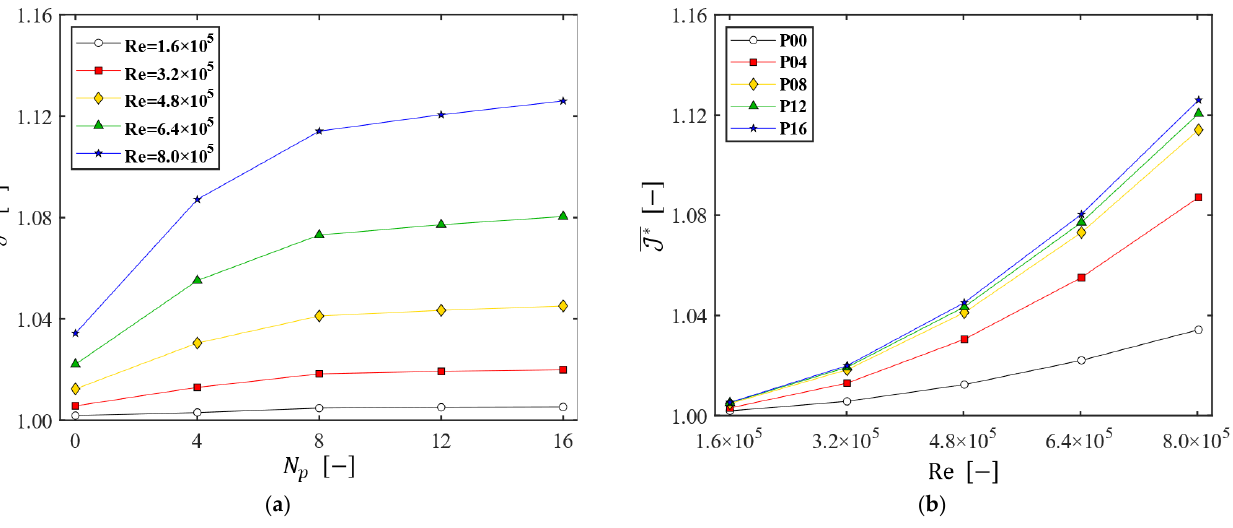
Figure 11. The line-averaged dimensionless permeate flux 𝒥 𝐿∗ as functions of the dimensionless radius ( 𝑟 ∗ = 𝑟/𝑅 𝑖 ) for the five disks, when ( a ) 𝛺 = 200 rpm ( Re = 1.6 × 10 5 ) and ( b ) 𝛺 = 1000 rpm ( Re = 8.0 × 10 5 ).